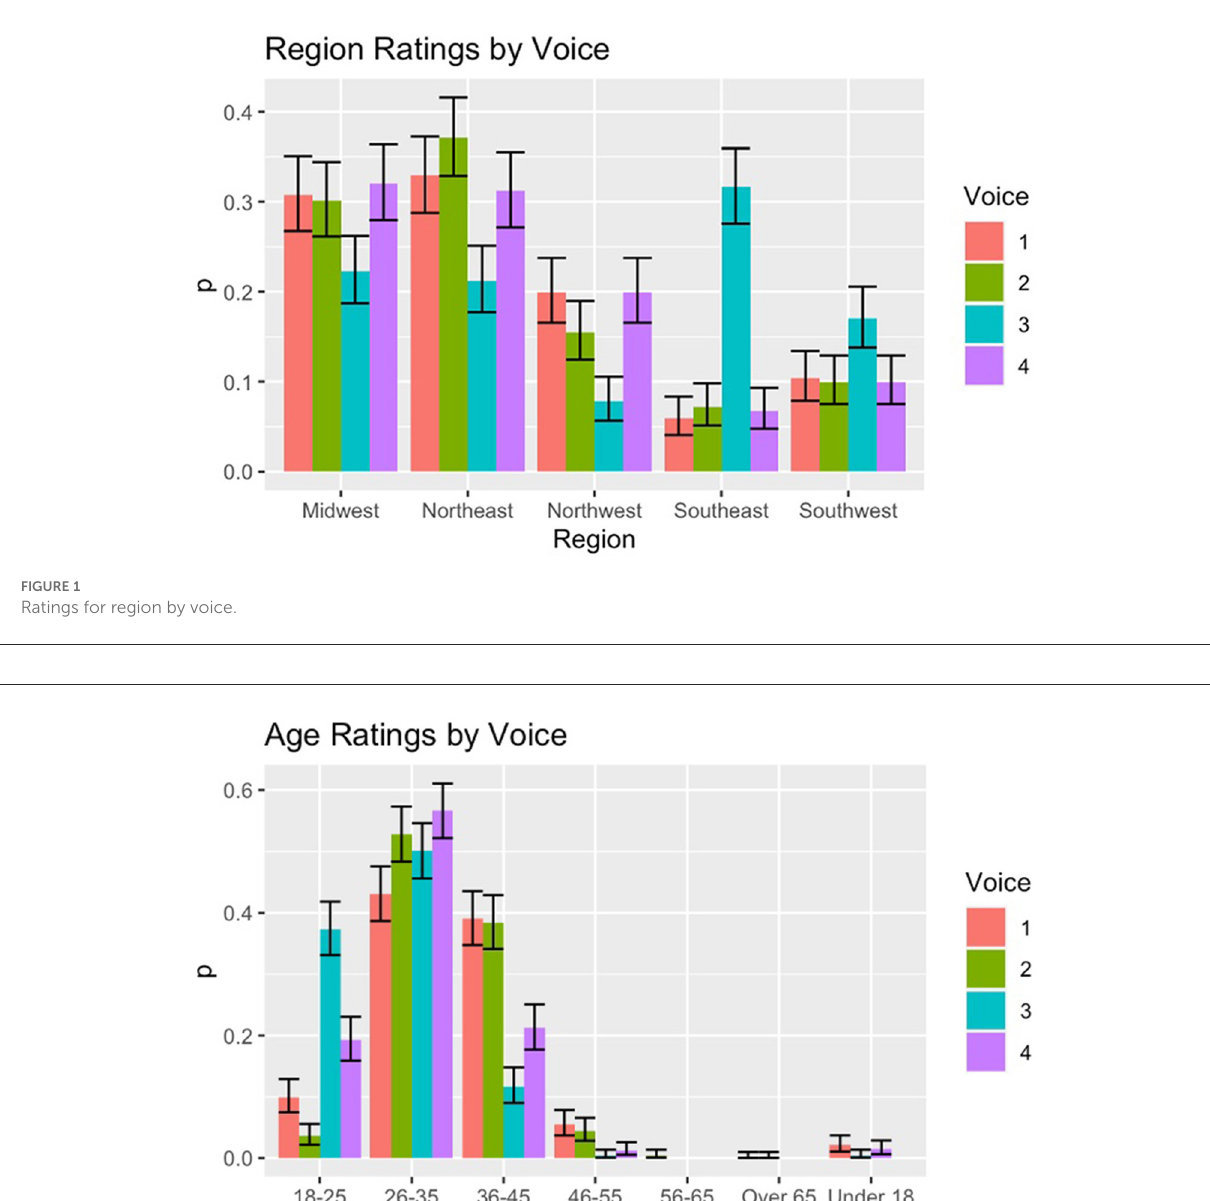
plot; of the study’s 485 listeners, only 8 ever selected the multiracial category for any of the